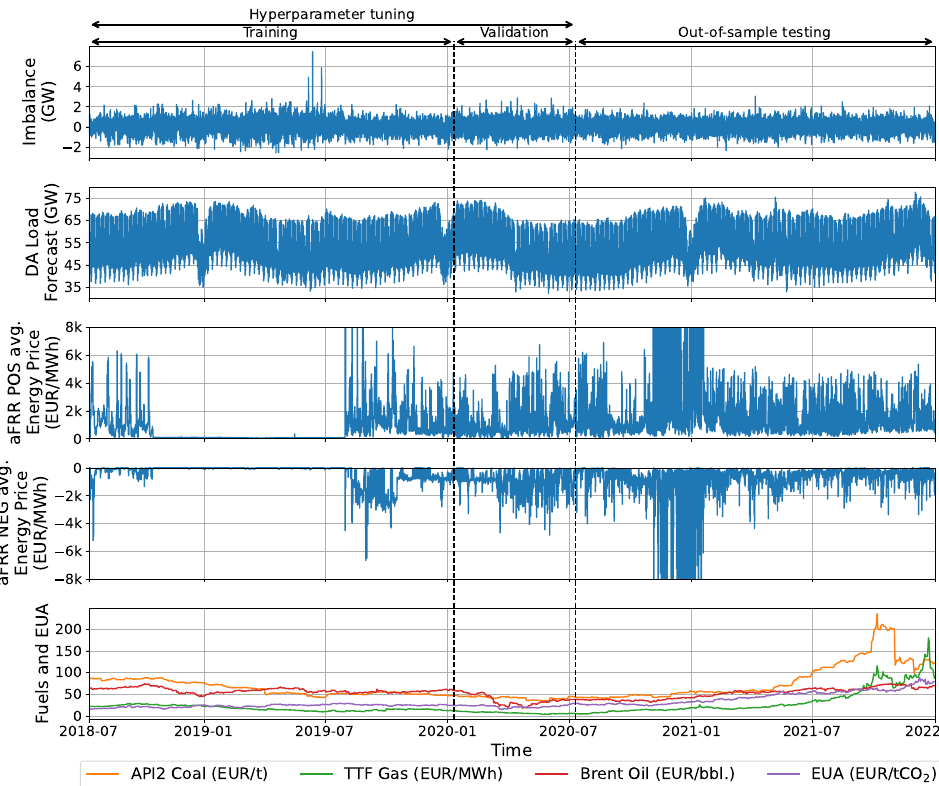
Figure 4. Time series plots of selected external regressors. POS and NEG stand for positive and negative,